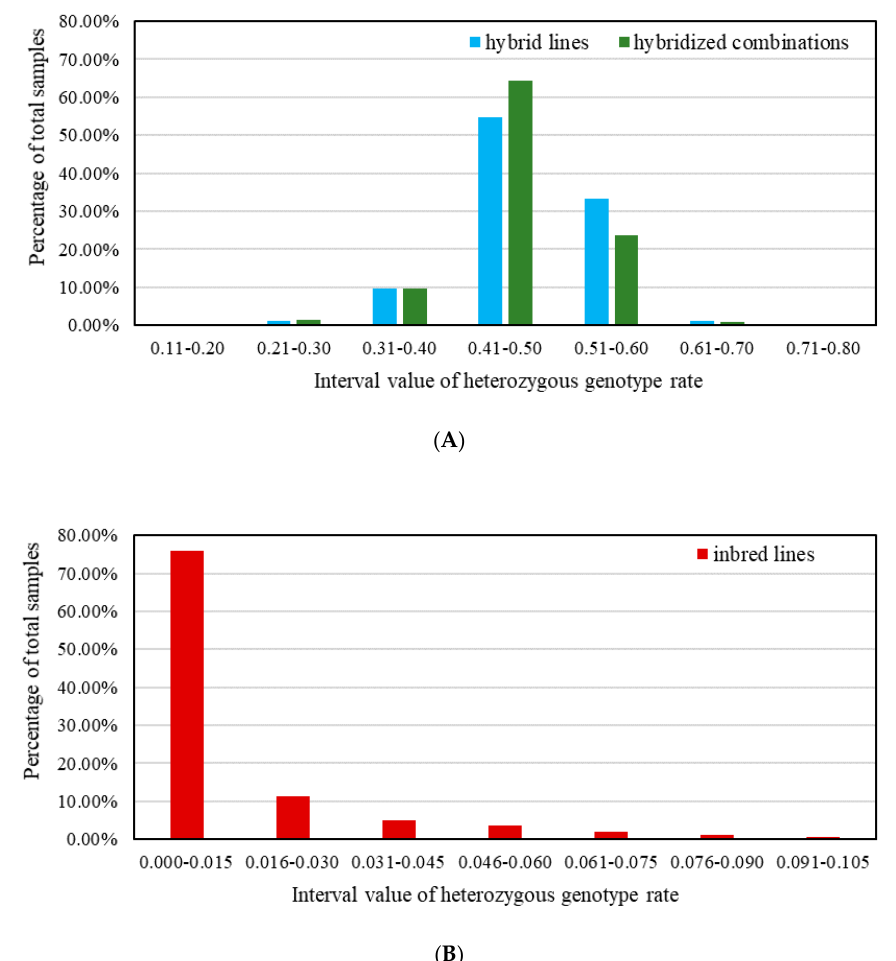
Figure 4. The distribution of heterozygous genotype rate of maize hybrid lines ( A ), hybridized combinations ( A ) and inbred lines ( B ).